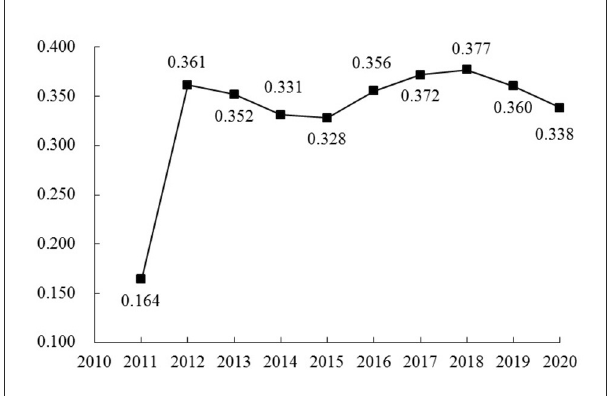
FIGURE1 The trend of tourism ecosystem health in China from 2011 to 2020.